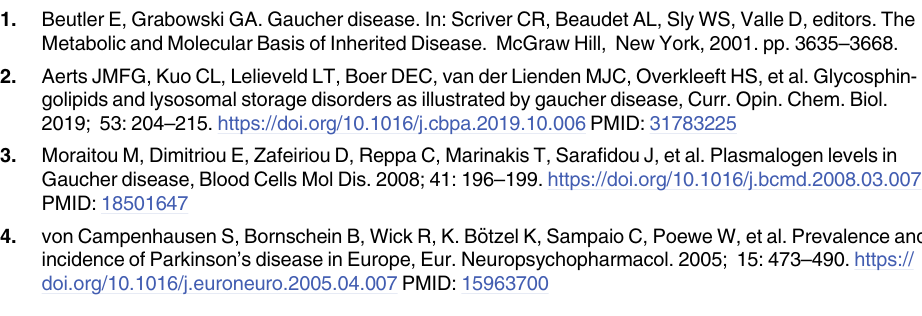
S3 Table. Red blood cell membrane levels and statistical comparison of the lipids studied in Gaucher disease patients receiving no treatment, Gaucher disease carriers and controls. S4 Table. Red blood cell membrane levels and statistical comparison of the α -synuclein species studied in Gaucher disease patients receiving no treatment, Gaucher disease carri- ers and controls. S5 Table. Red blood cell membrane levels and statistical comparison of the lipids studied in Gaucher disease patients before and after ERT. S6 Table. Red blood cell membrane levels and statistical comparison of the α -synuclein species studied in Gaucher disease patients before and after